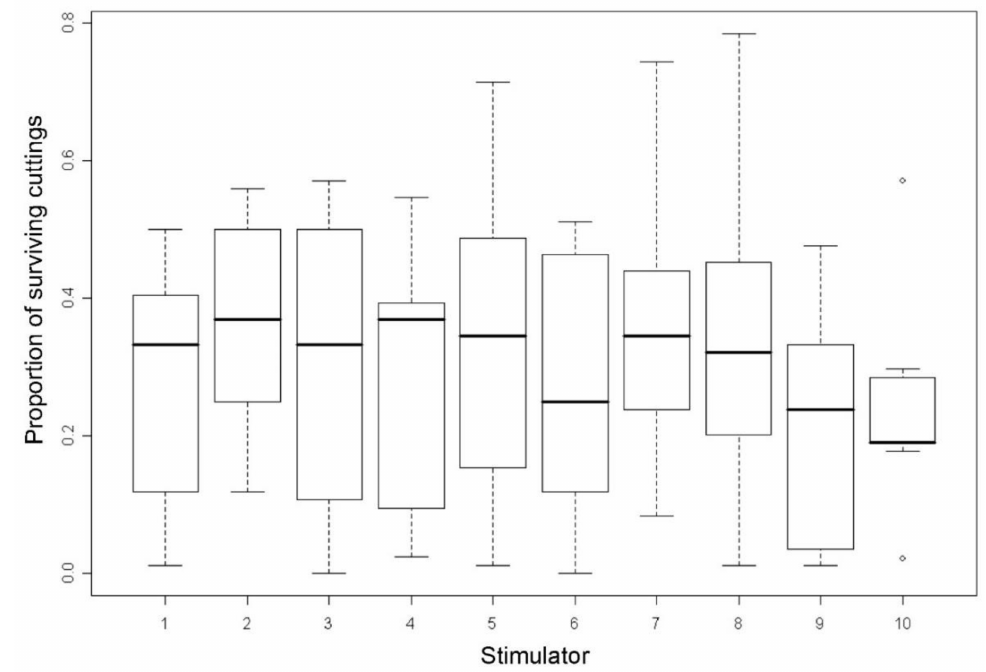
Figure 5. Box plot of the proportions of survived cuttings from the total number of cuttings in relation to the stimulator. The horizontal line in each box represents the median, the hinges represent the 25th and 75th percentiles, the whiskers represent 1.5 times the interquartile range and open circles represent values outside this interval.